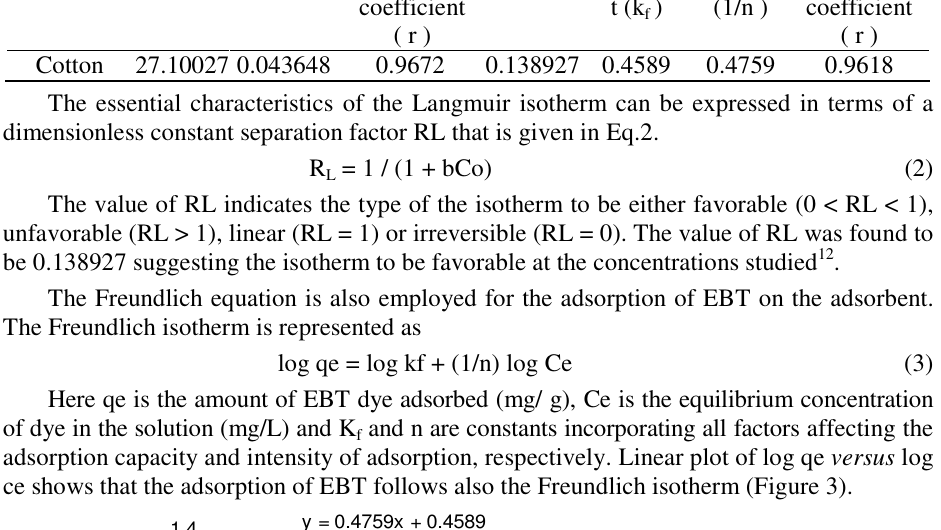
Figure 2 . Langmuir isotherm for the removal of EBT by adsorption on CSAC Table 4. Langmuir and Freundlich parameters of adsorption isotherms Langmuir isotherm Freundlich isotherm Adsorbents Correlation